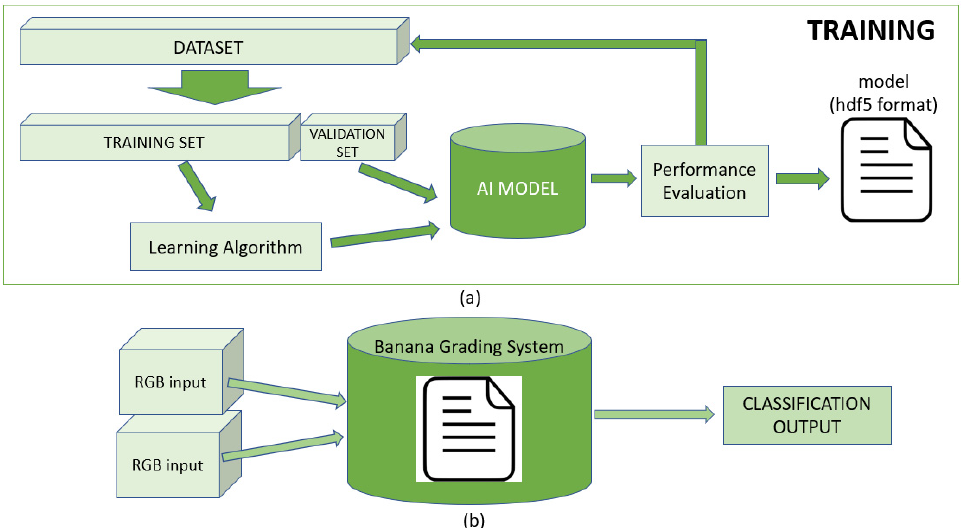
Figure 6. Data flow for training the AI model, ( a ) training process, and ( b ) basic setup for classification using the trained model.